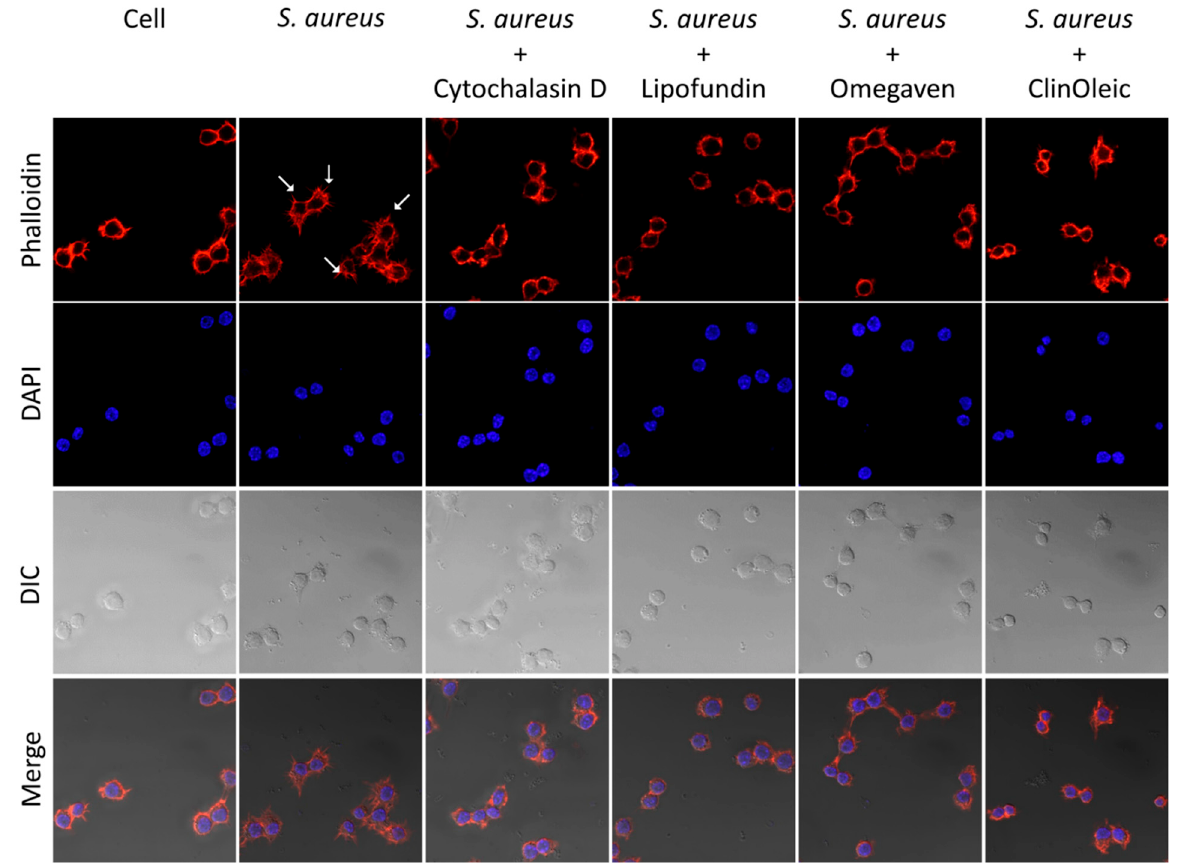
Figure 4. The three lipid emulsion-induced morphology changes in the cytoskeleton. S. aureus -infected mouse RAW264.7 macrophages were treated with or without lipid emulsions and further stained with Alexa-Fluor 568-labeled phalloidin to visualize F-actin. Cytochalasin D (10 μ M) was used to block the phagocytosis of S. aureus . Cell morphology was observed by confocal microscopy (63 × ). The white arrow is filopodia.